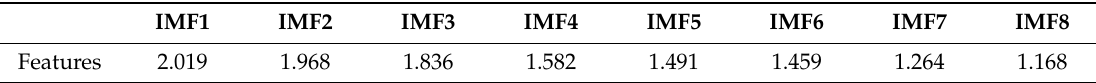
Table 2. The feature of IMFs.